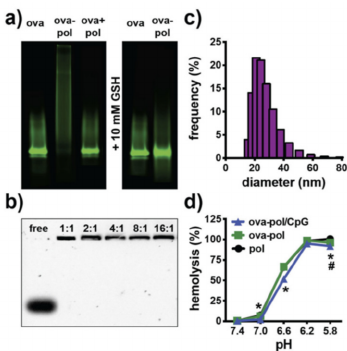
Figure 3. pH-responsive micellar nanocarriers for dual delivery of antigen and oligonucleotides. ( a ) SDS-PAGE of fluorescently labeled ovalbumin (OVA), nanoparticle–OVA conjugates at a poly- mer/OVA molar ratio of 20:1 (ova-pol), and a physical mixture of ova and polymer (ova+pol). Incubation of conjugates with intracellular concentrations of glutathione (GSH) liberates OVA from the carrier. ( b ) Agarose gel electrophoresis of OVA–nanoparticle conjugates incubated with CpG ODN1826 at various positive/negative charge ratios. ( c ) Representative size distribution (number average) measured by dynamic light scattering (DLS) of ova-pol/CpG complexes at a 4:1 charge ratio. ( d ) Erythrocyte lysis assay demonstrating pH-dependent membrane destabilizing activity of the diblock copolymer micelles (pol), nanoparticle–OVA conjugate (ova-pol), and conjugate complexed with CpG ODN (ova-pol/CpG). Concentrations are normalized to 2.5 µ g/mL polymer and data represent mean +/ − s.d. (n = 4). * p < 0.05: ova − pol/CpG vs. pol and ova − pol; # p < 0.05: ova − pol vs. pol by ANOVAwith Tukey’s post hoc test. (Adapted from